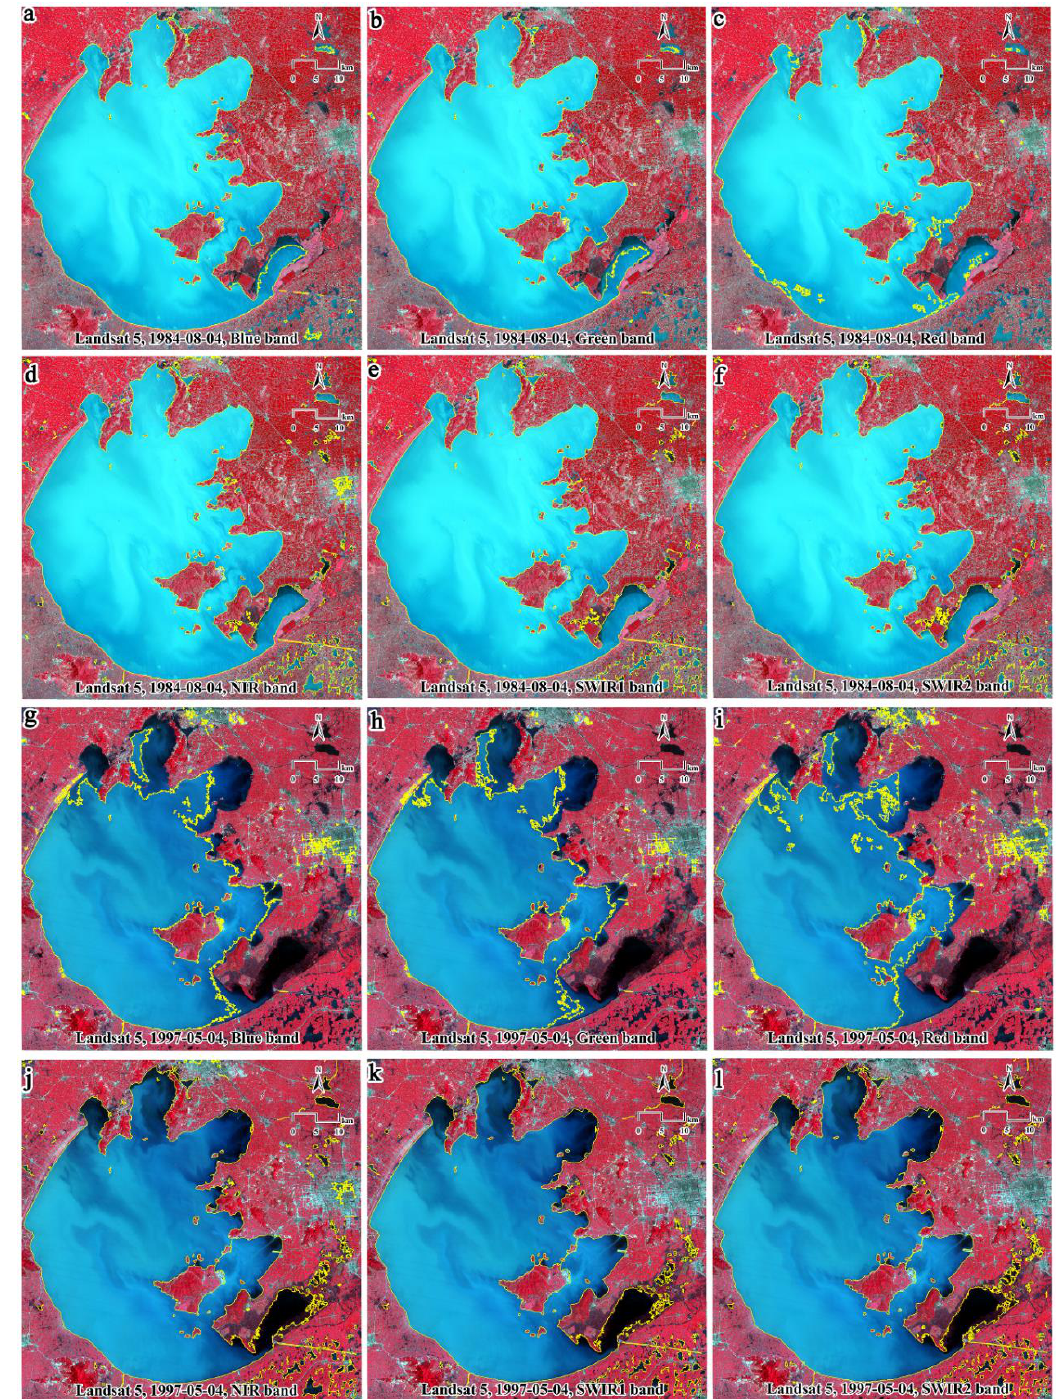
Figure 4. Sample water extraction results of Landsat TM imagery (the yellow line is the extracted water boundary, and the background image is with standard false color composition). Water extraction results from blue ( a ), green ( b ), red ( c ), near infrared ( d ), first shortwave infrared ( e ), and second shortwave infrared bands ( f ) of Landsat TM acquired in 1984-08-04. Water extraction results from blue ( g ), green ( h ), red ( i ), near infrared ( j ), first shortwave infrared ( k ), and second shortwave infrared ( l ) bands of Landsat TM acquired in 1997-05-04.